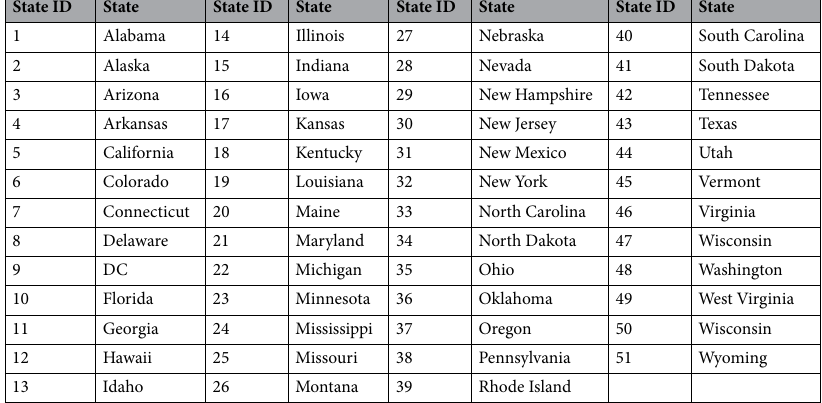
“50% of US population at least vaccinated by one dose”. There are two dynamic shifts (lines “ 5 ” and “ 7 ”) which are not correlated with the “net actions” we have studied. These happen on the dates that the centers of clusters experienced a “jump”, as can be seen from Fig. 6a.